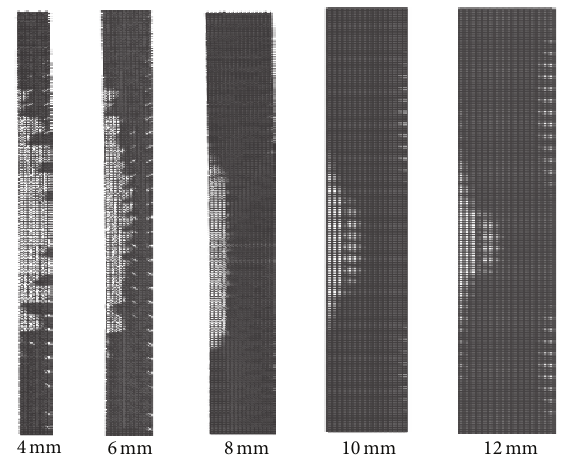
Figure 9: Interface failure diagram under different flange’s